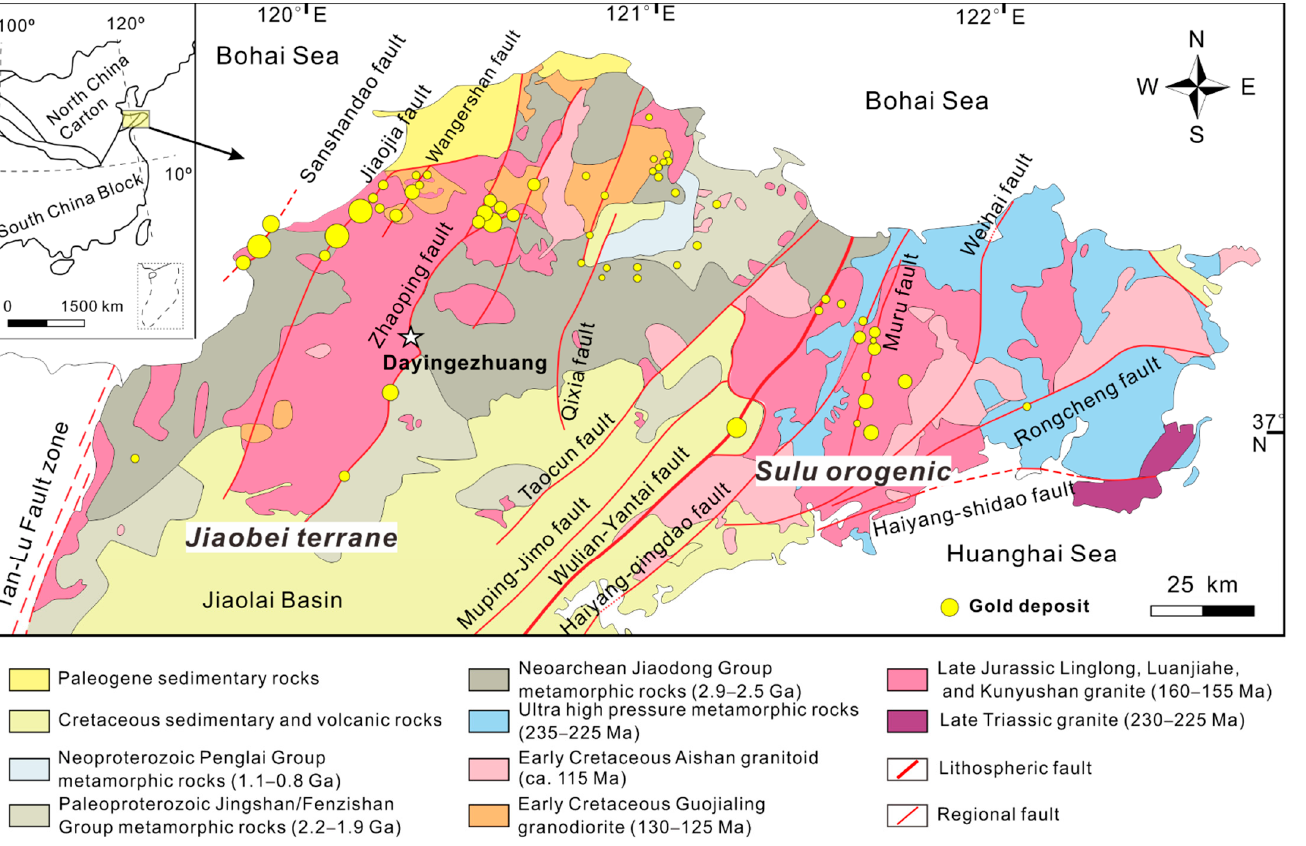
Figure 1. Geological map of the Jiaodong gold province showing the distribution of major fault zones, formations, intrusions, and gold deposits (modified from